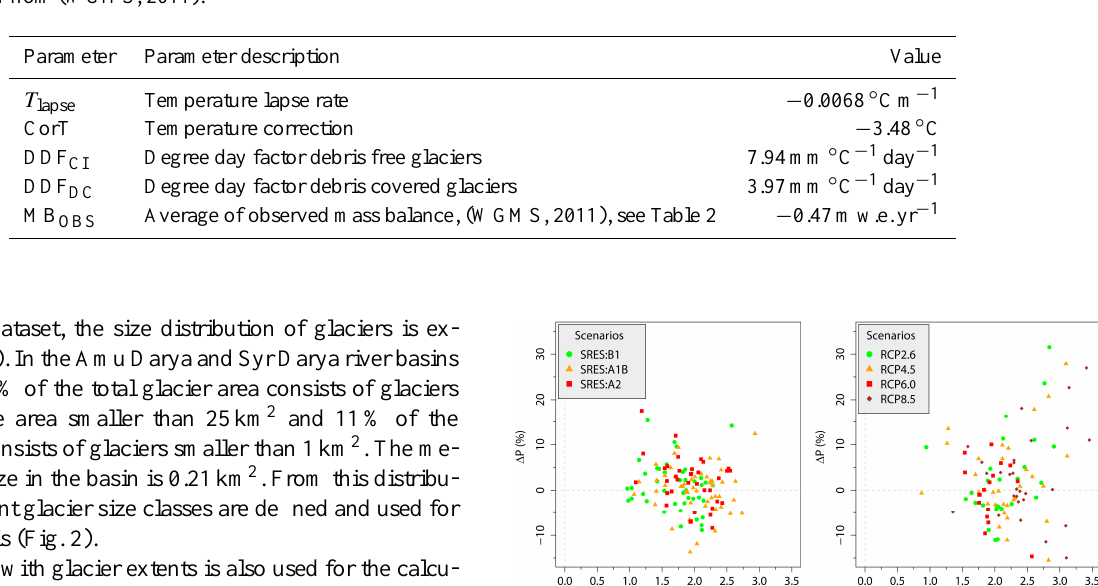
Table 1. Model parameters used in the glacier model. DDF CI and DDF DC were calibrated in a related study (Immerzeel et al., 2012a), MB OBS is taken from (WGMS, 2011).